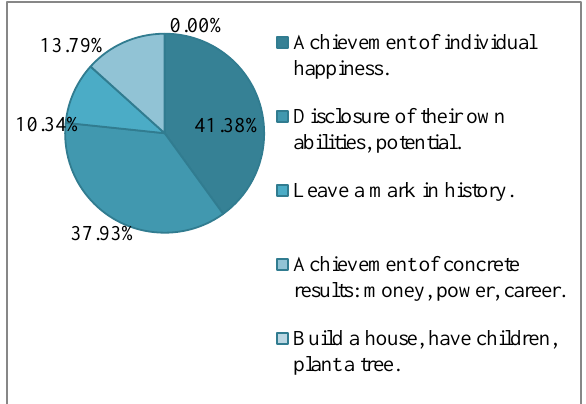
Fig. 3. The goal of human self-realization through the eyes of graduate students.